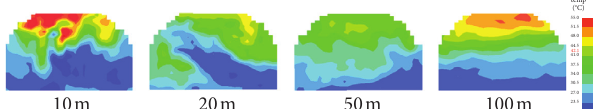
Figure 8: Temperature field change in each cross section of calculation condition